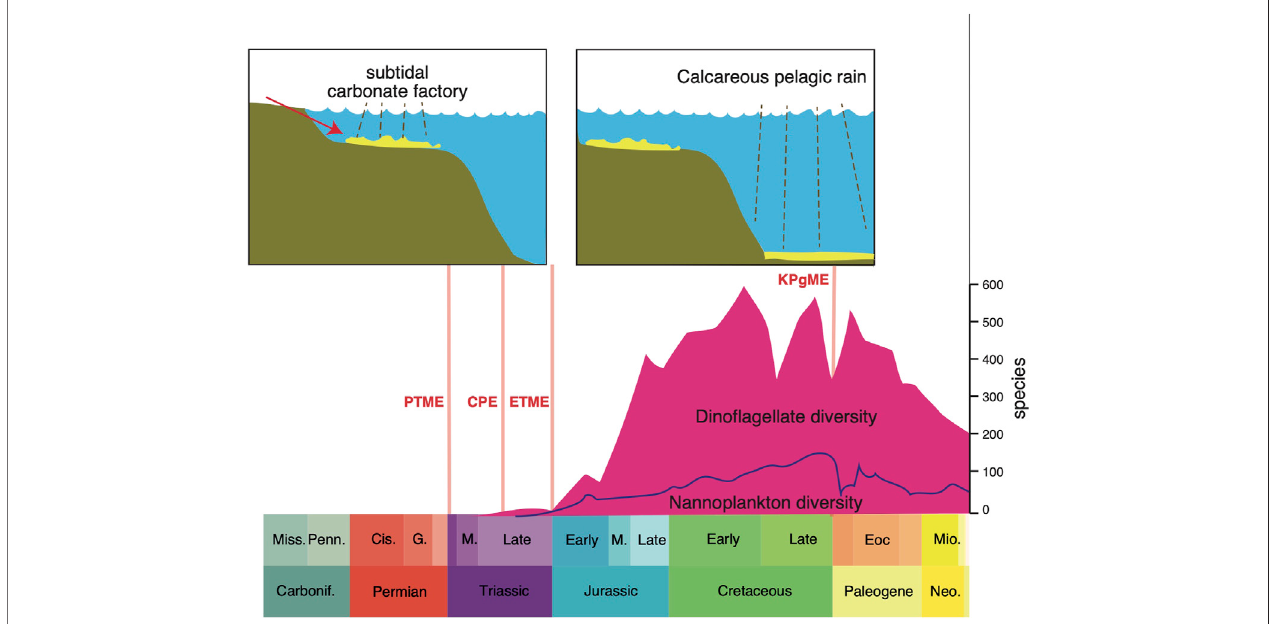
FIGURE1| Themajorshiftinthemarinecarbonatefactoryfromtheshelf-basedmodelthroughthePalaeozoicandmostoftheTriassic,andthemodern-styledep- watercarbonatefactoryoftoday, whichbeganinthelatestTriassic.Abbreviations:Carbonif,Carboniferous;Cis,Cisuralian;CPE,CarnianPluvialEpisode;Eoc,Eocene; ETME, end-Triassic mass extinction; KPgME, Cretaceous-Paleogene mass extinction; M, Middle; Mio, Miocene; Miss, Mississippian; Neo, Neogene; Penn, Pennsylvanian;PTME,Permian-Triassicmassextinction.Dino fl agellatediversitythroughtimefromFensomeetal.(1996),NannoplanktondiversityfromBownetal. (2005), and sketch carbonate factory models based on James